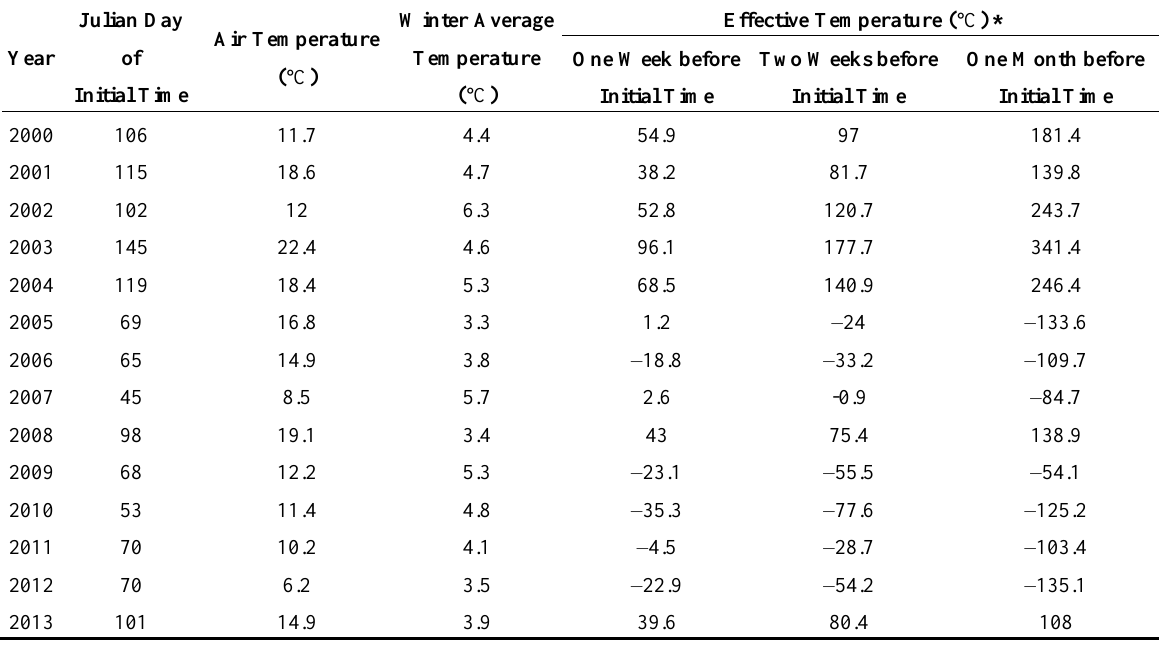
Table 5. General temperature features of floating algae at time of bloom formation in Lake Chaohu from 2000 to